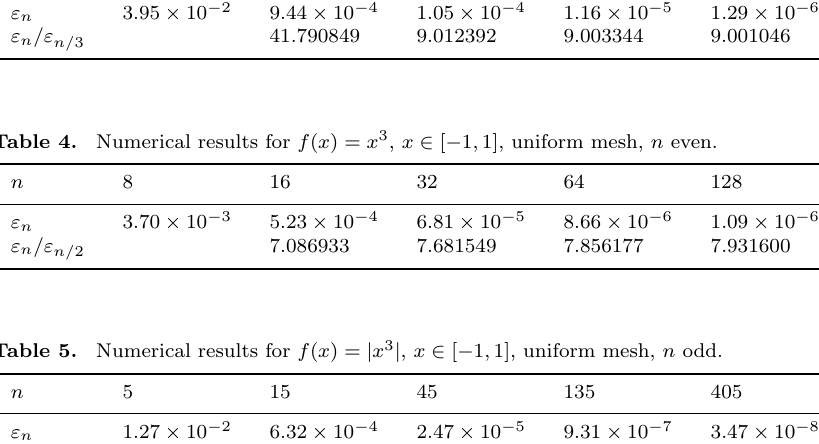
Table 3. Numerical results for f ( x ) = x 2 , x ∈ [ − 1 , 1], nonuniform mesh, n odd. n 5 ε n